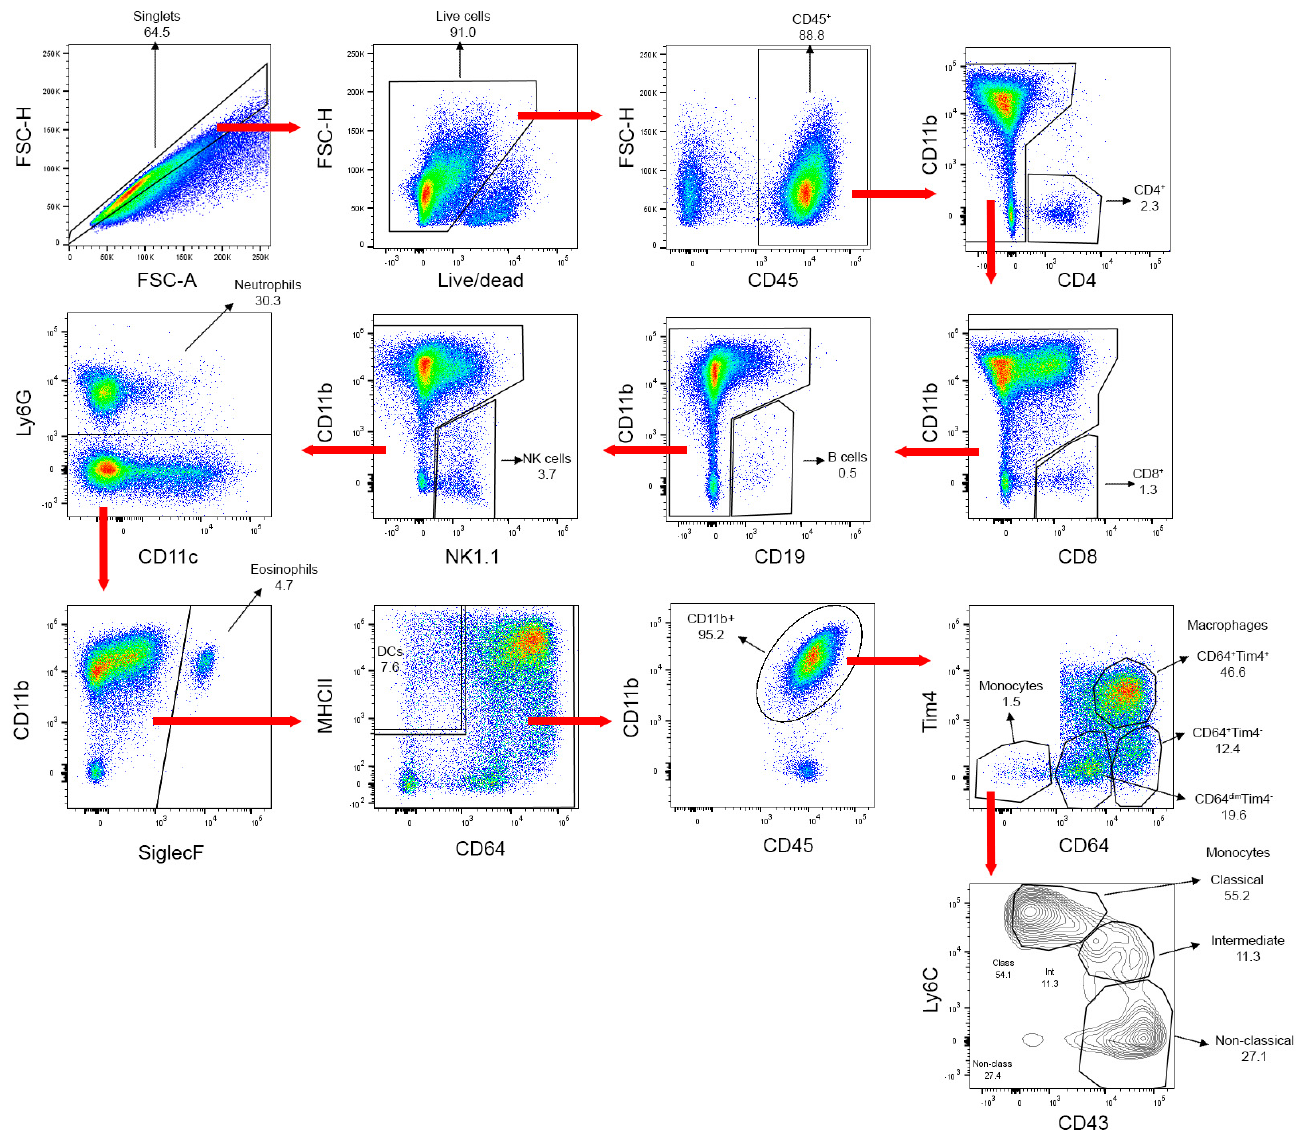
Figure 2. Gating strategy used to identify leukocytes and leukocyte sub-populations in a representa- tive sample with the 15-parameter flow cytometry panel. FSC-H, forward scatter height. FSC-A, forward scatter area. NK cells, natural killer cells. DCs, dendritic cells.